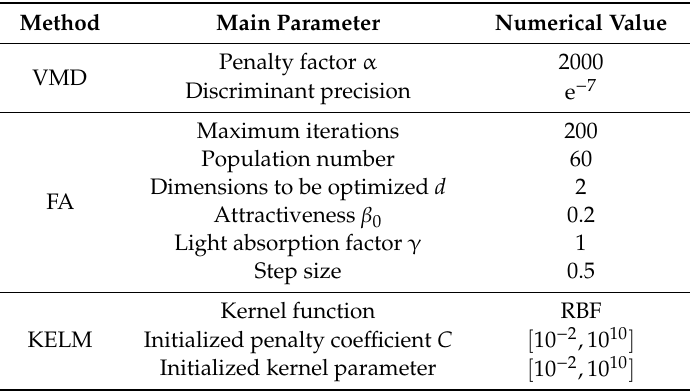
Table 4. Parameters in the VMD-FA-KELM